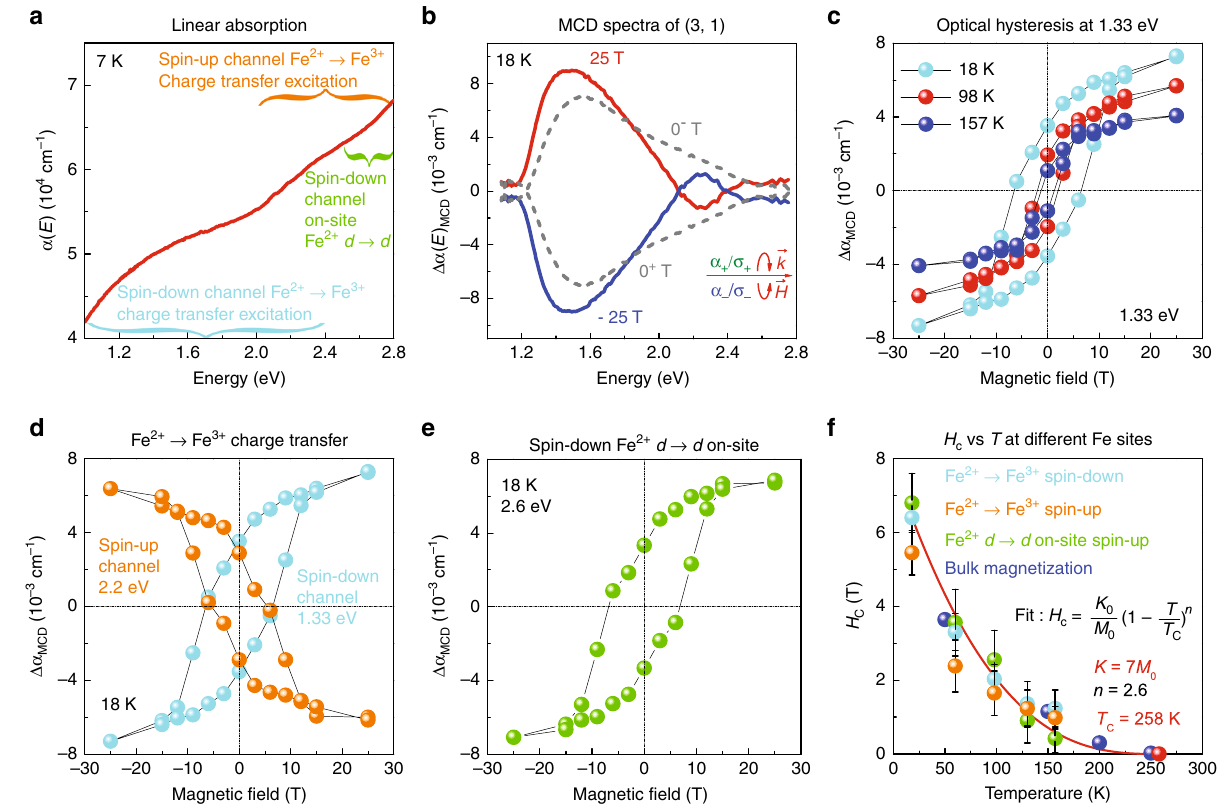
Fig. 2 Linear absorption spectrum, magnetic circular dichroism, and the magnetic behavior of different Fe centers in (LuFeO 3 ) 3 /(LuFe 2 O 4 ) 1 . a Linear absorption spectrum of the (3, 1) superlattice. The three most important Fe-related excitations are indicated. b Magnetic circular dichroism spectra of the (3, 1) superlattice at ±25 and ±0 T after substrate correction. c Fixed energy cut of the magnetic circular dichroism spectrum at 1.33 eV as a function of magnetic fi eld at various temperatures. d Optical hysteresis loop obtained from the analysis of the Fe 2 + → Fe 3 + charge-transfer excitation in the spin-up channel compared to that in the spin-down channel. e Hysteretic behavior of the Fe 2 + on-site d -to- d excitation in the spin-down channel. f Coercive fi elds extracted from the optical hysteresis loops for each type of excitation as a function of temperature. The model fi t is described in the text. Bulk magnetization is included for comparison 21 1.33 eV vs. magnetic fi eld unveils an optical hysteresis loop